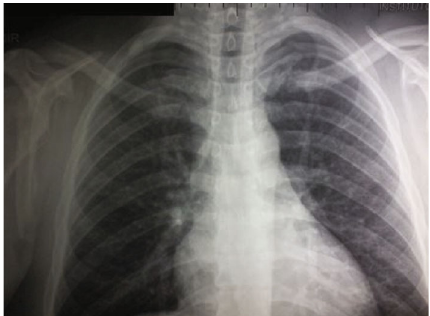
Figure 1: Anteroposterior chest radiography performed at the emergency department, showing fracture of the medial ends of both